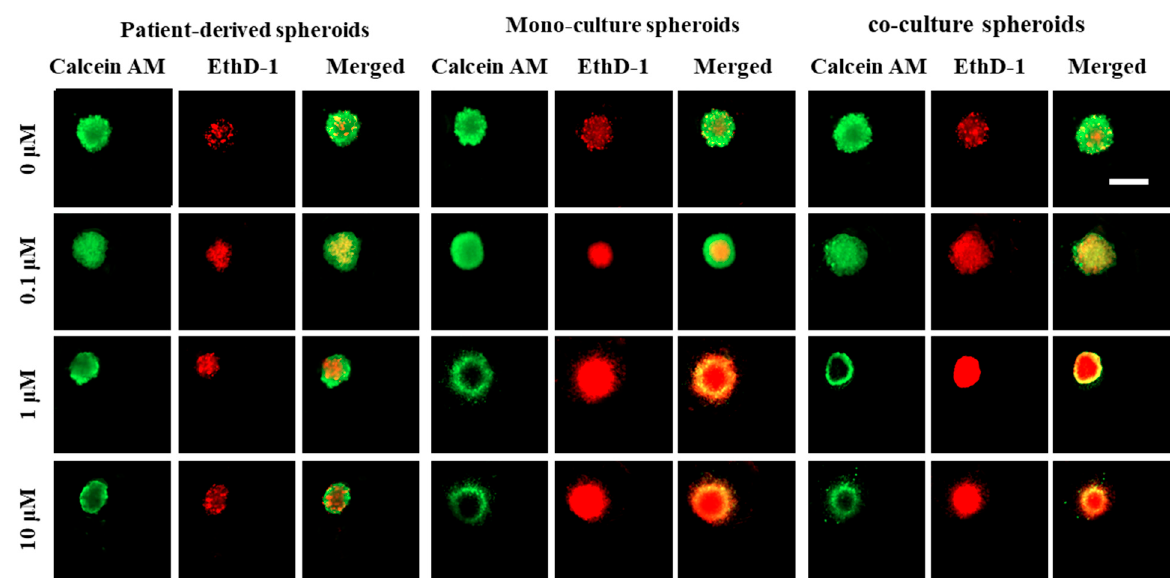
Figure 6. Images of differential staining (live/dead assay) captured by fluorescent microscopy. The green color is due to the Calcein AM and it represents the distribution of the live cells in the spheroids. The red color is due to the EthD-1 and it represents the dead cells in the spheroids. In all three groups of cells, an increase in the area of dead cells and a decrease in the area of the live cells were observed by increasing the drug concentrations. The initial total number of cells was 1 × 10 6 cells/mL for all experiments. A ratio of 1:1 was considered for the co-culture model of lung tumor cells A549 and primary human osteoblasts by keeping the total initial cells at 1 × 10 6 cells/mL. All assays were performed as triplicates per trial in three independent experiments. Images represent a repetitive phenomenon observed in three independent experiments. The error bar represents 200 µM.